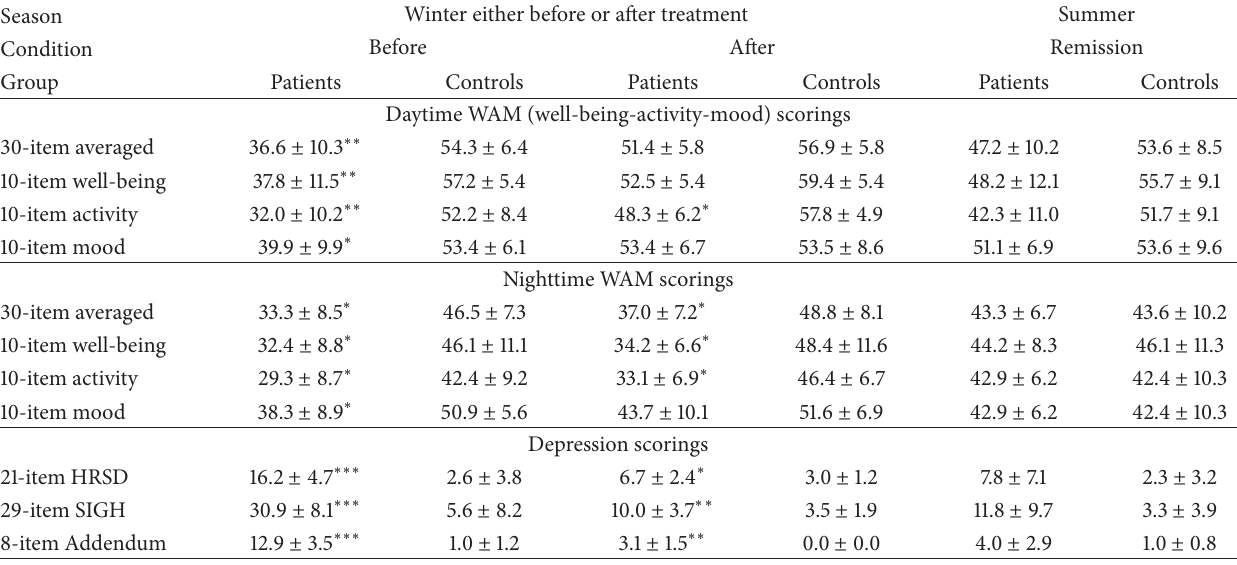
Table 1: Results of 𝑡 -test aimed at comparison of assessments of subjective state.